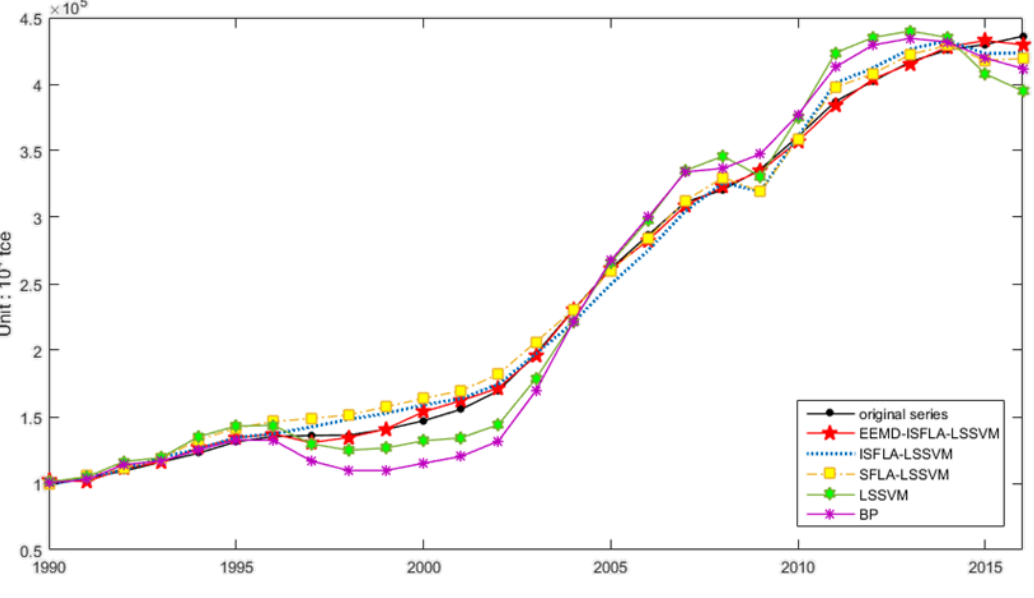
Figure 8. Comparison of forecasting results.